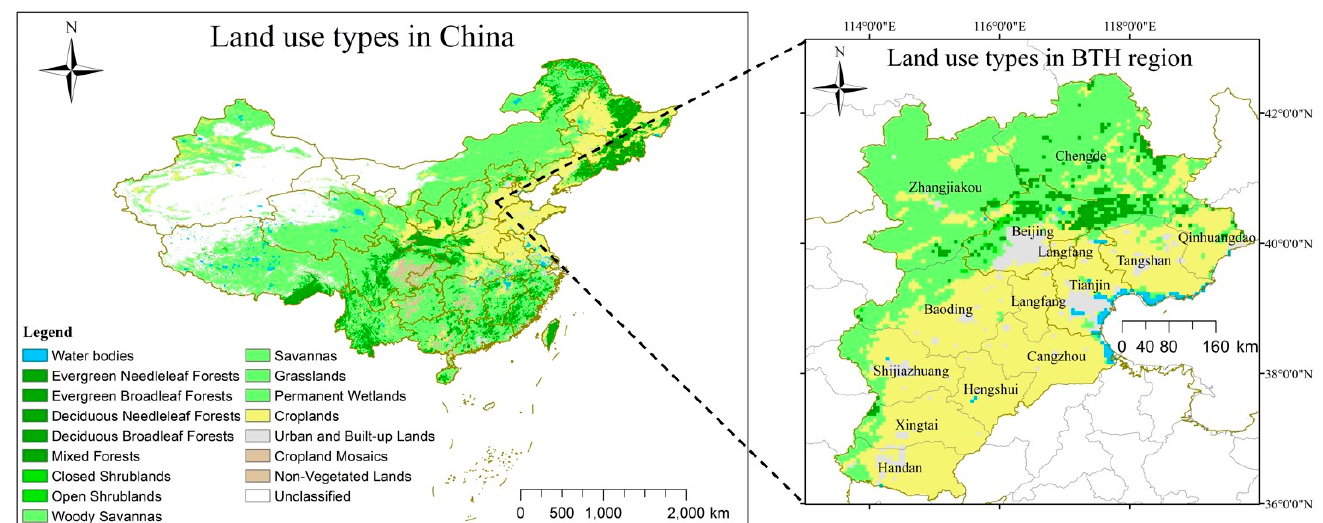
Figure 1. Land use types in the Beijing–Tianjin–Hebei (BTH) region in China.